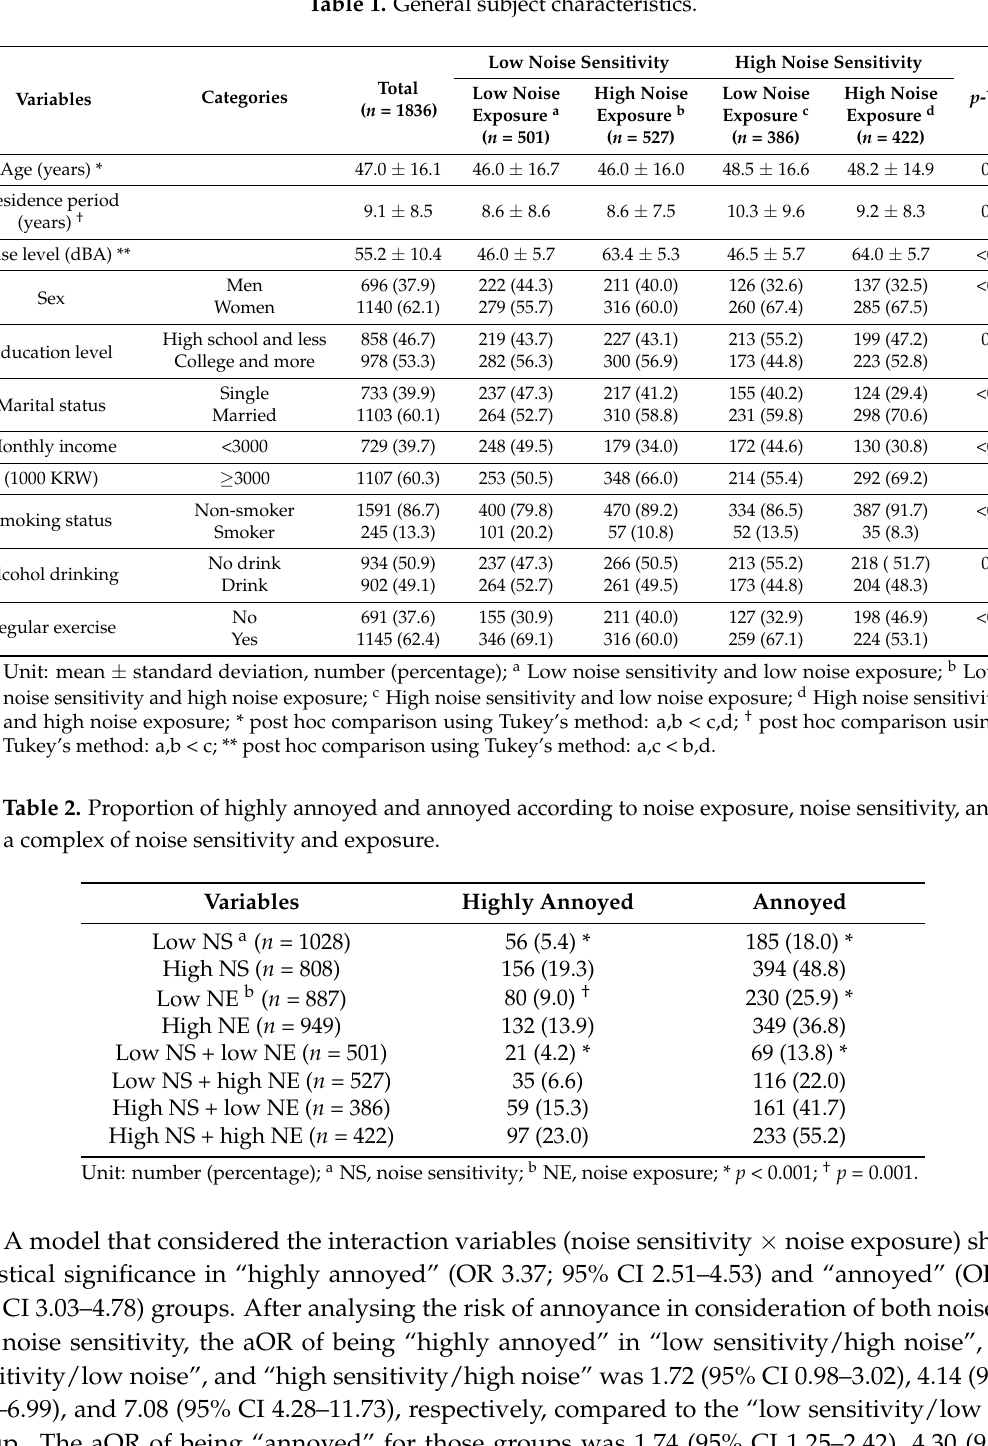
Table 1. General subject characteristics.